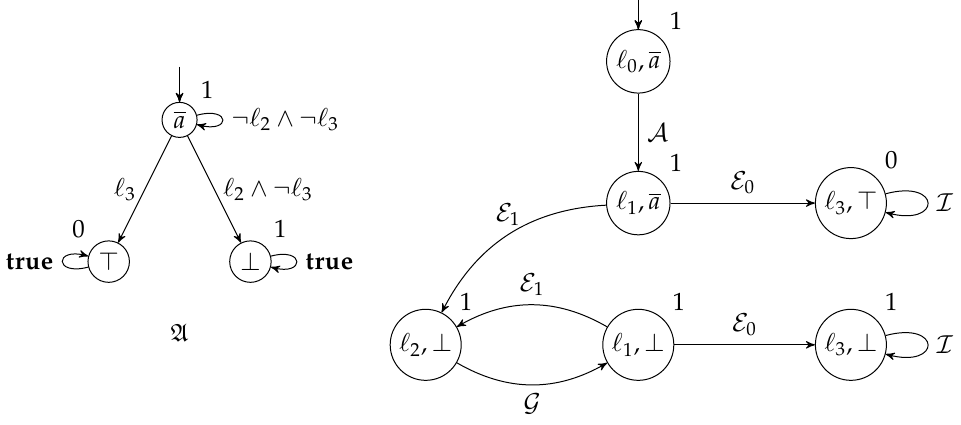
Figure 3. Parity construction for the QMC from Figure 1 and the LTL formula ( ¬ (cid:96) 2 ) U (cid:96) 3